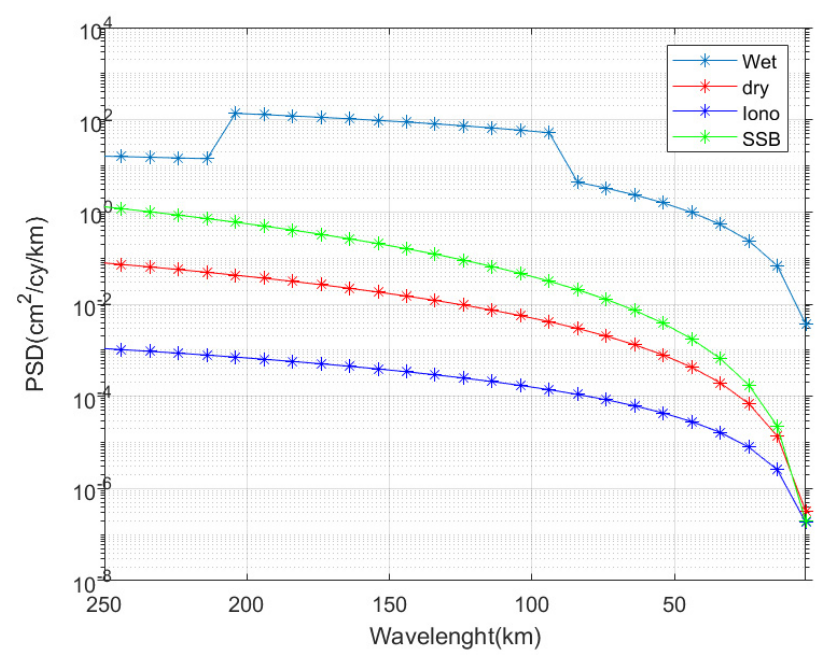
Figure 2. PSD of errors in environmental corrections.